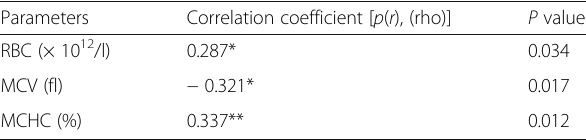
Table 4 Correlations of duration of petrol exposure with hematological parameters of petrol station workers